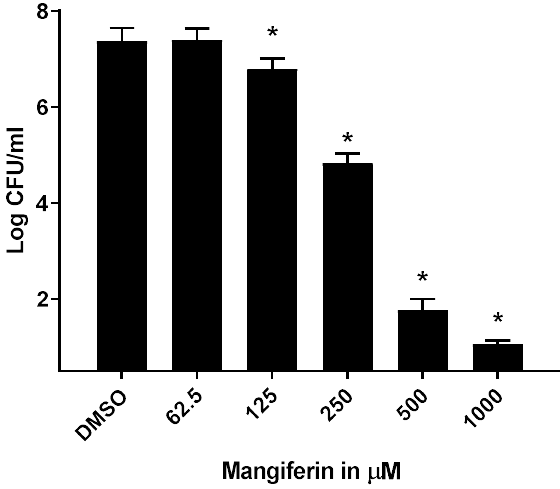
Figure 4. E ff ect of mangiferin on S. mutans biofilm in teeth analyzed as viable colony forming units. Data are means ± standard deviations (SD) (n = 3). * p < 0.05 represents statistical significant di ff erence from the control